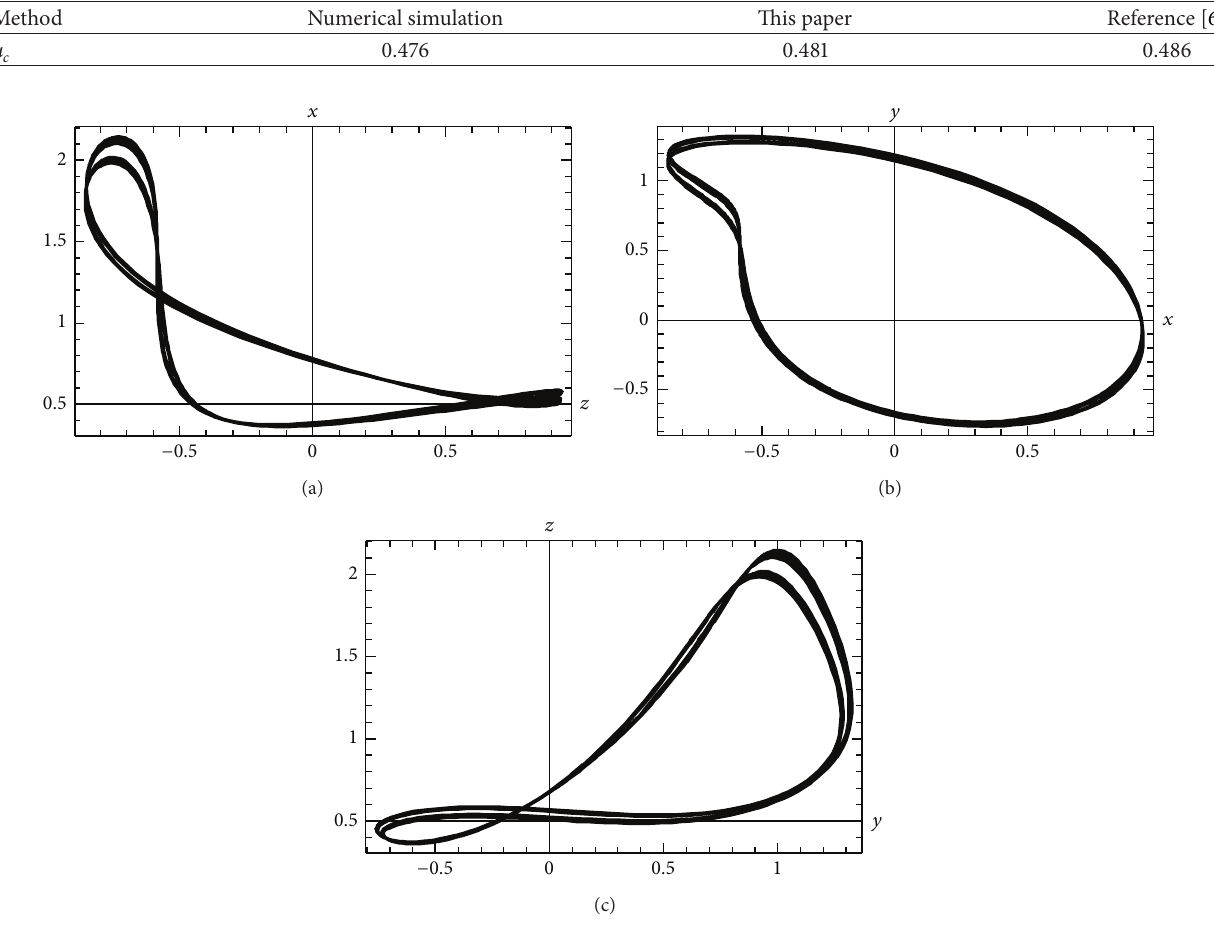
Figure 1: Projections on (𝑧,𝑥) , (𝑥,𝑦) , and (𝑦,𝑧) plane of the first period-doubling